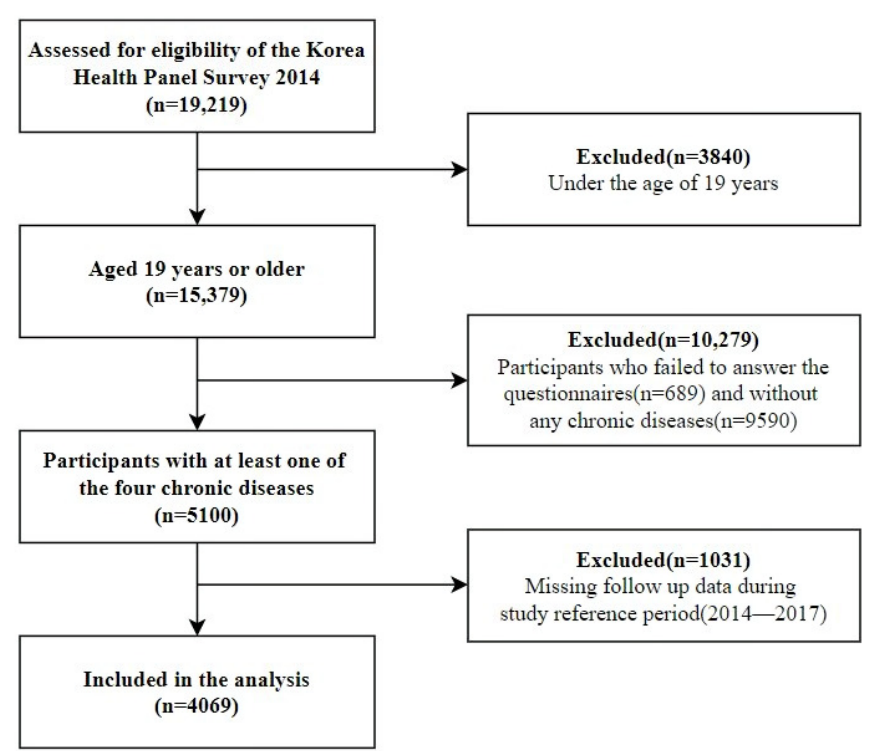
Figure 1. Flowchart of the participant selection.